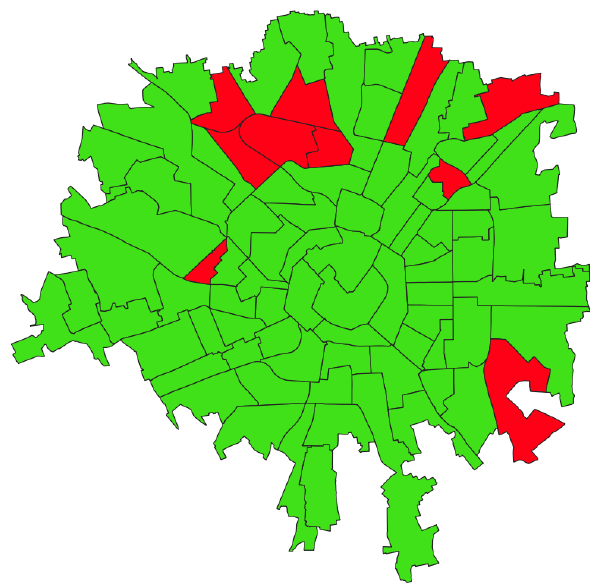
Figure 4. Hierarchical clustering on young people education and occupation data with 2 clusters